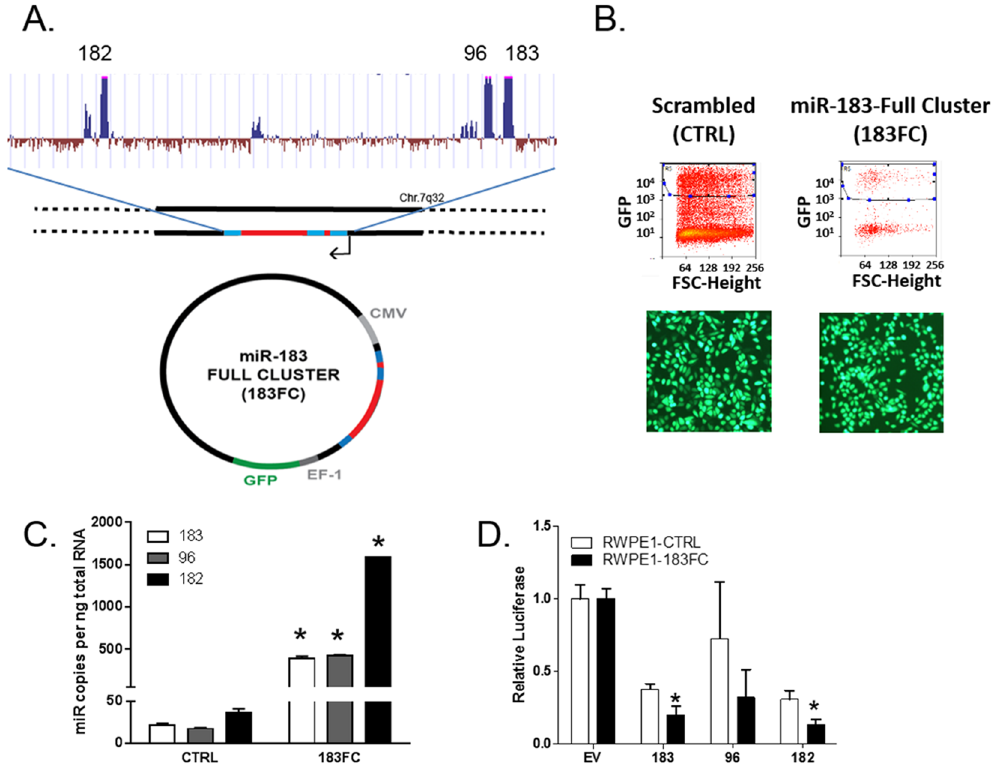
Figure 1. Overexpression of the miR-183 family cluster in benign prostate epithelial cells. ( A ) The gene for the miR-183 family cluster was isolated from male genomic DNA using nested PCR and cloned into CD511B-1 Lentiviral plasmid. ( B ) Sorting of GFP + RWPE1-CTRL and RWPE1-183FC cells for homogeneous polyclonal population. ( C ) Expression of mature miRs-183, -96 and -182 by RT-qPCR in RWPE1 cells. Absolute quantitation from a standard curve and normalized to RNU44. Mean of N = 6 shown with SEM. ( D ) luciferase levels of plasmids containing the miR consensus sequences in the 3 ′ UTR transiently transfected in RWPE1- CTRL and RWPE1-183FC. Graphs show mean data − / + SEM (n = 2) relative to empty vector without miR sites in the 3 ′ UTR (EV). * p < 0.05 CTRL versus 183FC by Student’s paired 2-sided